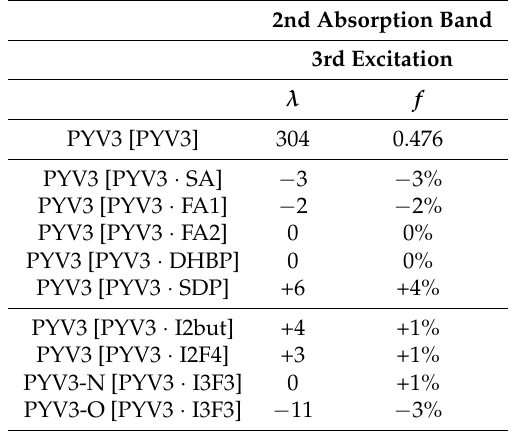
Table A5. RI-CC2/def2-TZVPD wavelengths of excitation, λ in nm, and oscillator strengths, f , for the keto PYV3 molecule in its crystal (PYV3 [PYV3]) and its co-crystals (PYV3 [PYV3 · XXX]). For PYV3 [PYV3], the absolute values are given while for the co-crystals, the absolute variations and relative variations are given for the wavelengths and oscillator strengths, respectively.